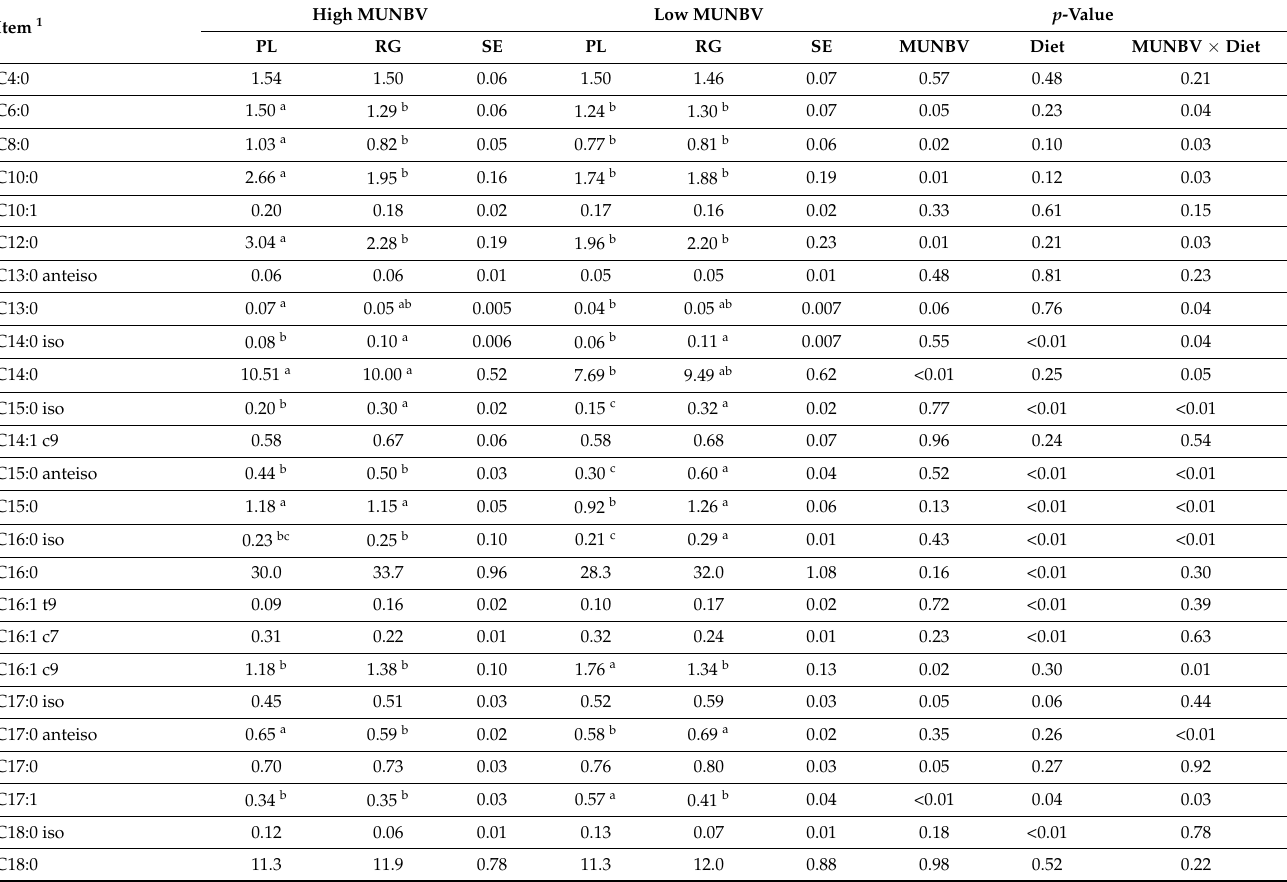
Table 4. Milk fatty acids composition (g/100 g) for cows considered divergent for milk urea nitrogen breeding values (MUNBV) consuming a diet of either plantain (PL) or ryegrass